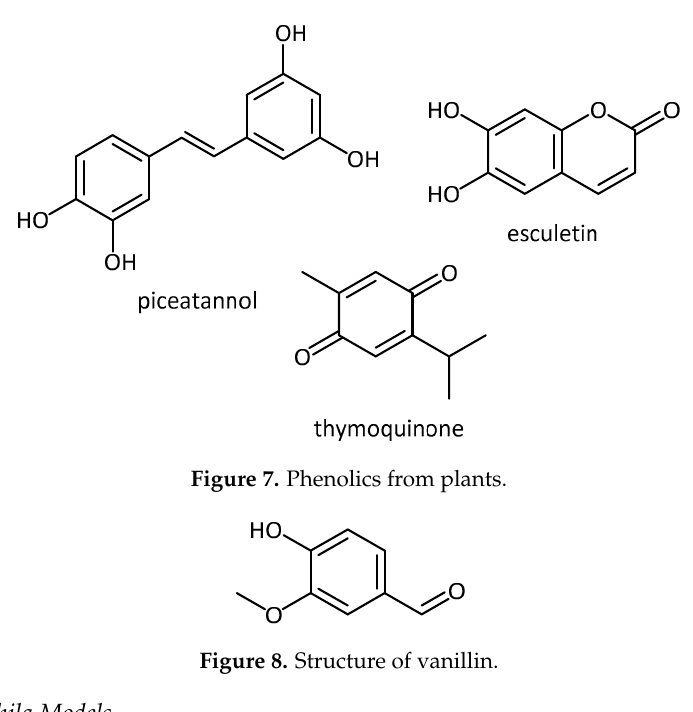
Figure 8. Structure of vanillin.